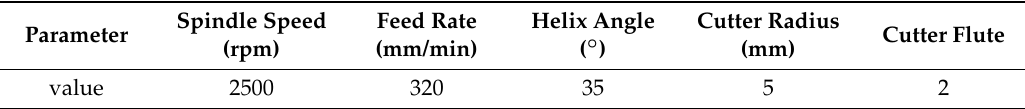
Table 1. Main cutting parameters and tool parameters.